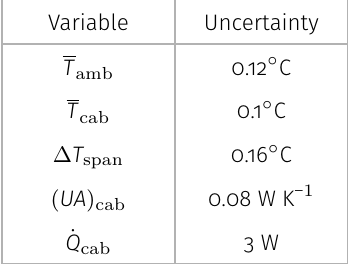
Table III. Summary of the experimental uncertainties (95% confidence interval) of the variables associated with the determination of the cabinet thermal load. Variable